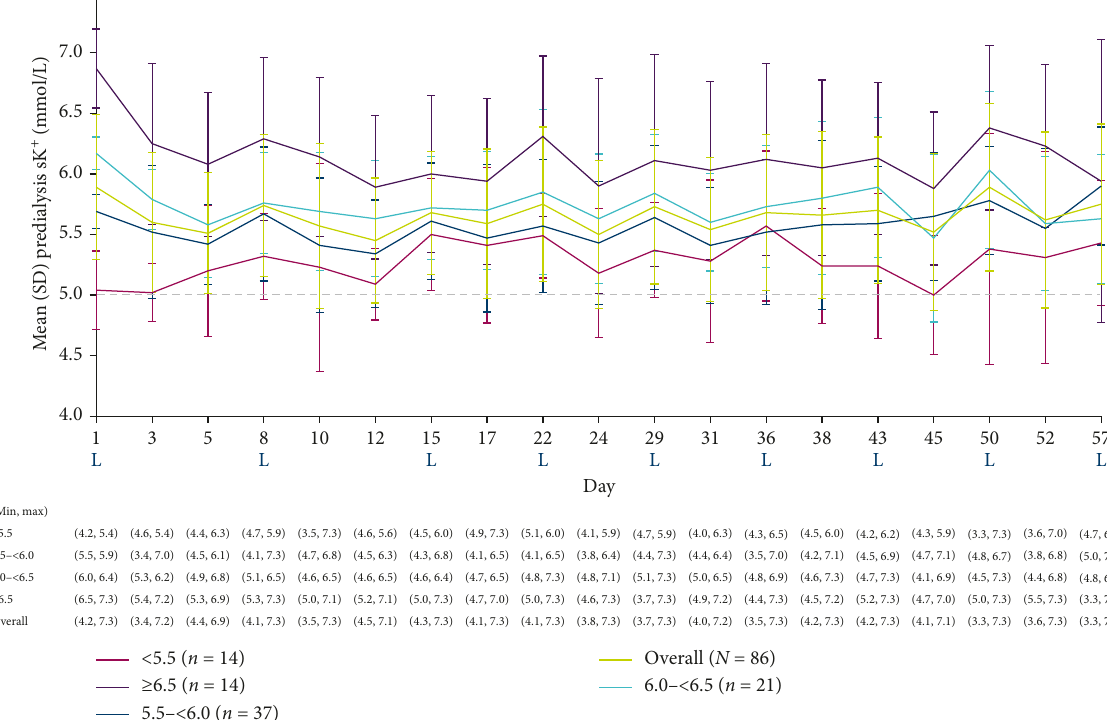
Figure 1: Predialysis sK + concentration at each study visit in placebo patients overall and by predialysis sK + concentration at randomization. Predialysis sK + measurement at randomization (visit 4, day 1) was used for subgroup stratification. No imputation of missing data was conducted. The dashed line represents the upper limit of normokalemia (i.e., sK + 5.0mmol/L). L represents the LIDI visits. LIDI, long interdialytic interval; SD, standard deviation; sK + , serum potassium.